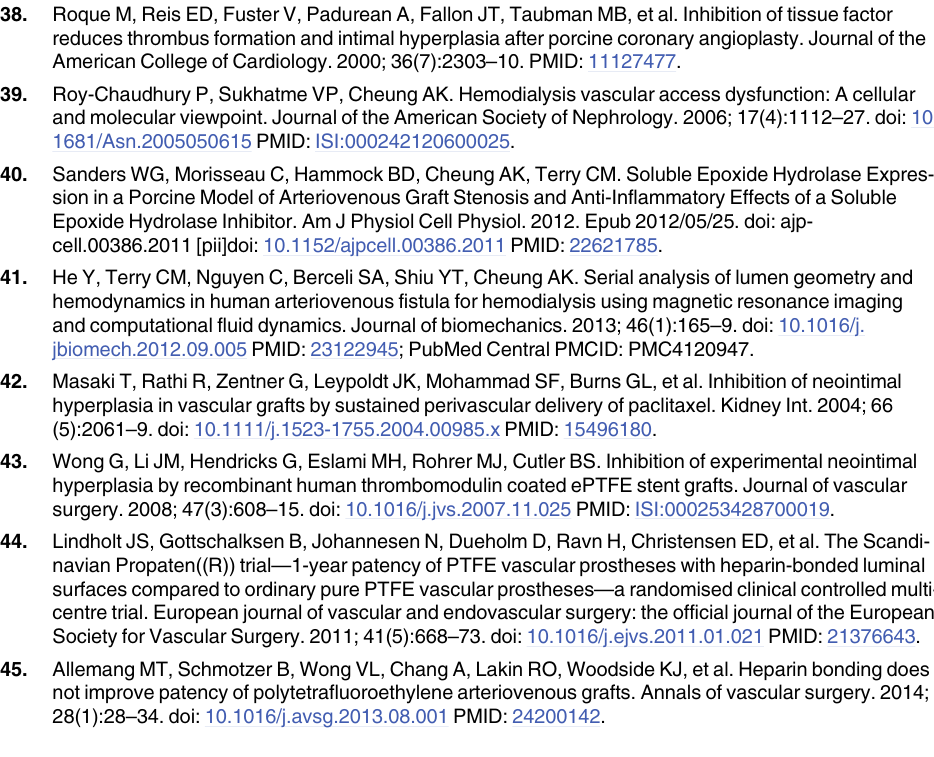
PLOS ONE | DOI:10.1371/journal.pone.0137381 September 11, 2015 15 /